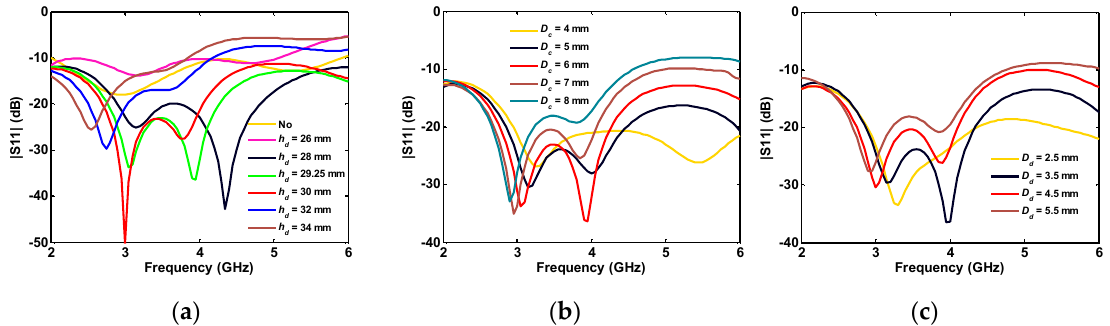
Figure 5. Single-port antenna simulated reflection coefficient for different ( a ) location; ( b ) width; and ( c ) height of the dumbbell-shaped etched ground.